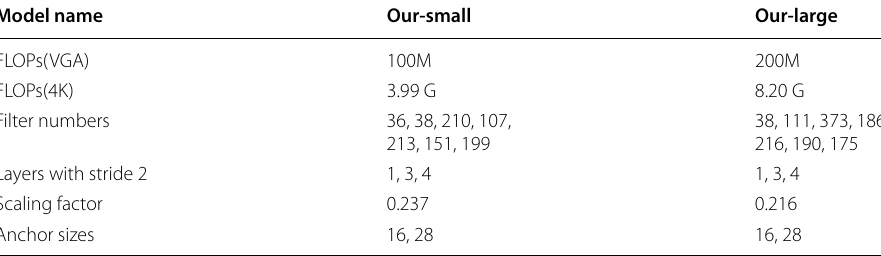
Table 1 The settings and searched parameters of the proposed